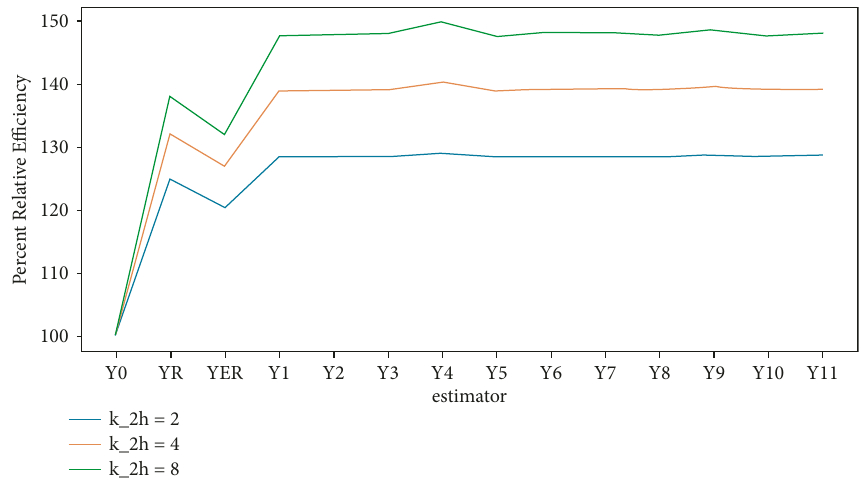
Figure 6: Plot of PREs at 20% nonresponse and 0.8 sensitivity level for population II.